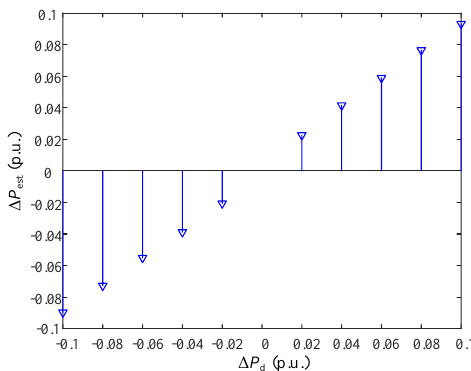
Table 1. Disturbance estimation and relative error.